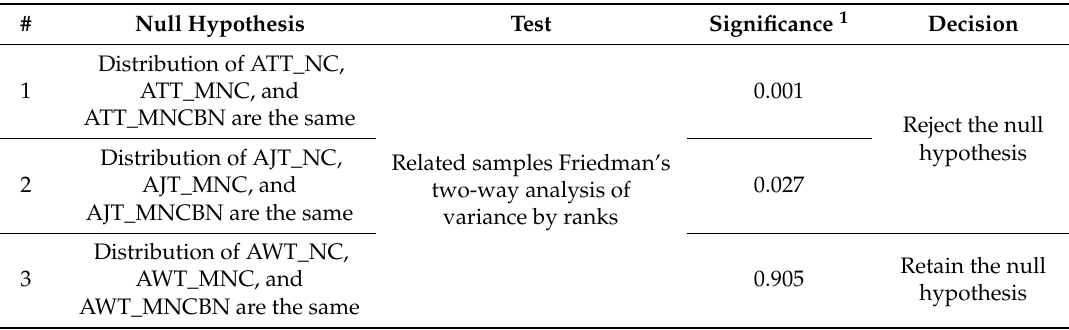
Table 4. Hypothesis test